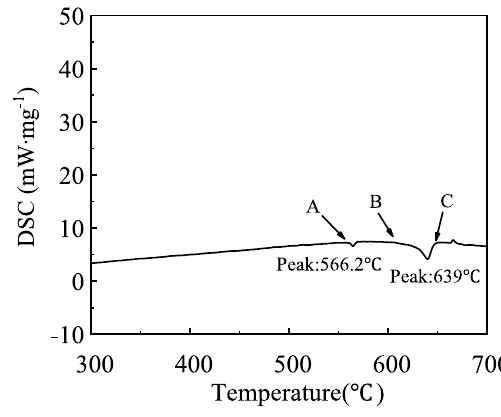
Fig. 5 XRD patterns of WE43 magnesium alloy EBW joint